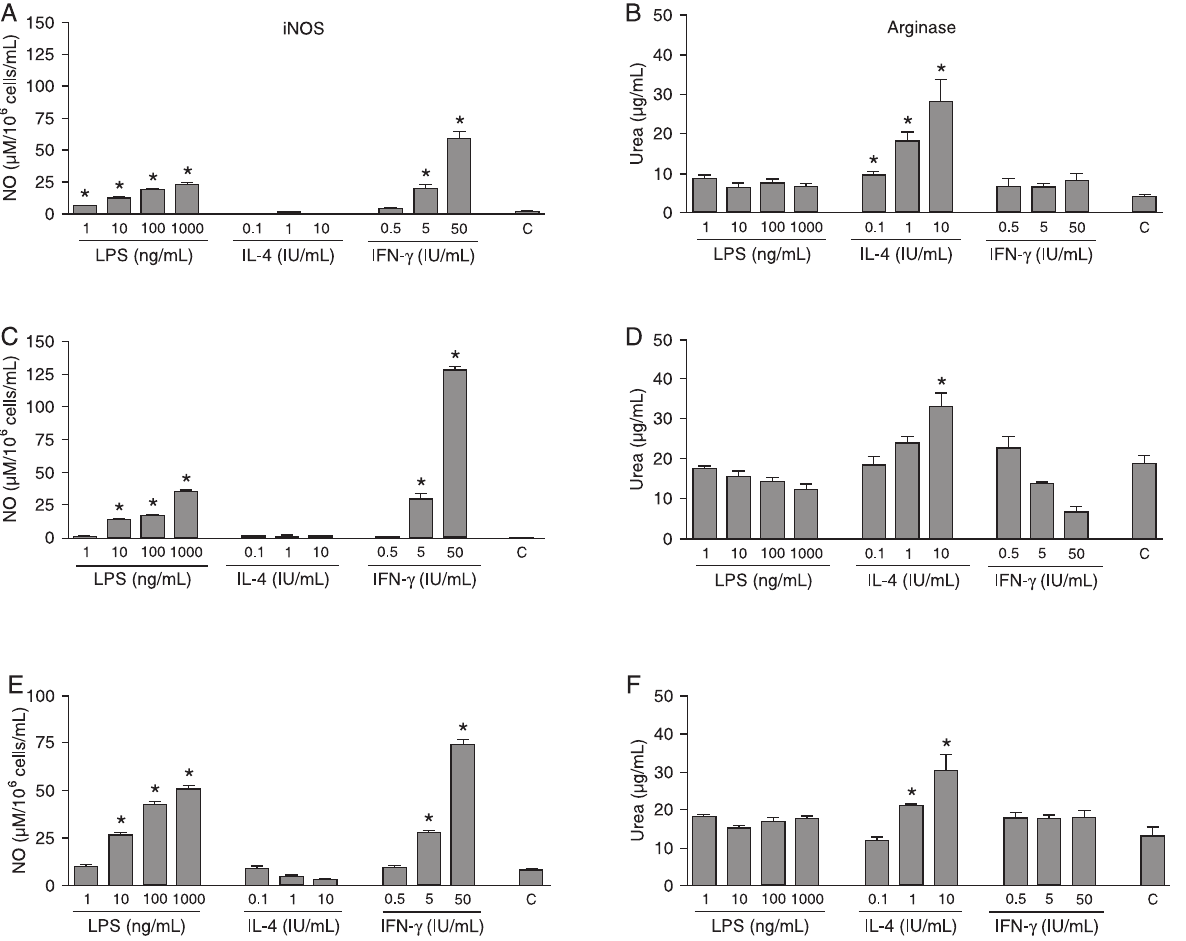
Figure 1. Inducible nitric oxide synthase (iNOS) and arginase activities in macrophages of young BALB/c mice: effects of lipopolysac- charide (LPS), interleukin-4 (IL-4) and interferon-γ (IFN-γ). A and B , Peritoneal macrophages from naive mice; C and D , peritoneal macrophages from thioglycolate-elicited mice; E and F , bone marrow-derived macrophages. Adherent cells from 6 mice per group were incubated in the presence of LPS (1, 10, 100, and 1000 ng/mL), IL-4 (0.1, 1, and 10 IU/mL) or IFN-γ (0.5, 5, and 50 IU/mL) for 48 h; all studies were conducted in triplicate. Cells of control groups (C) were incubated in the absence of stimuli. Nitrite was measured in the culture supernatants using Griess reagent, and arginase activity was determined in cell lysates on the basis of the amounts of urea produced from L-arginine. Bars indicate the means ± SEM of nitrite (Panels A, C, and E) and urea (Panels B, D, and F) levels in three independent experiments. *P ≤ 0.05 compared to control (Student t